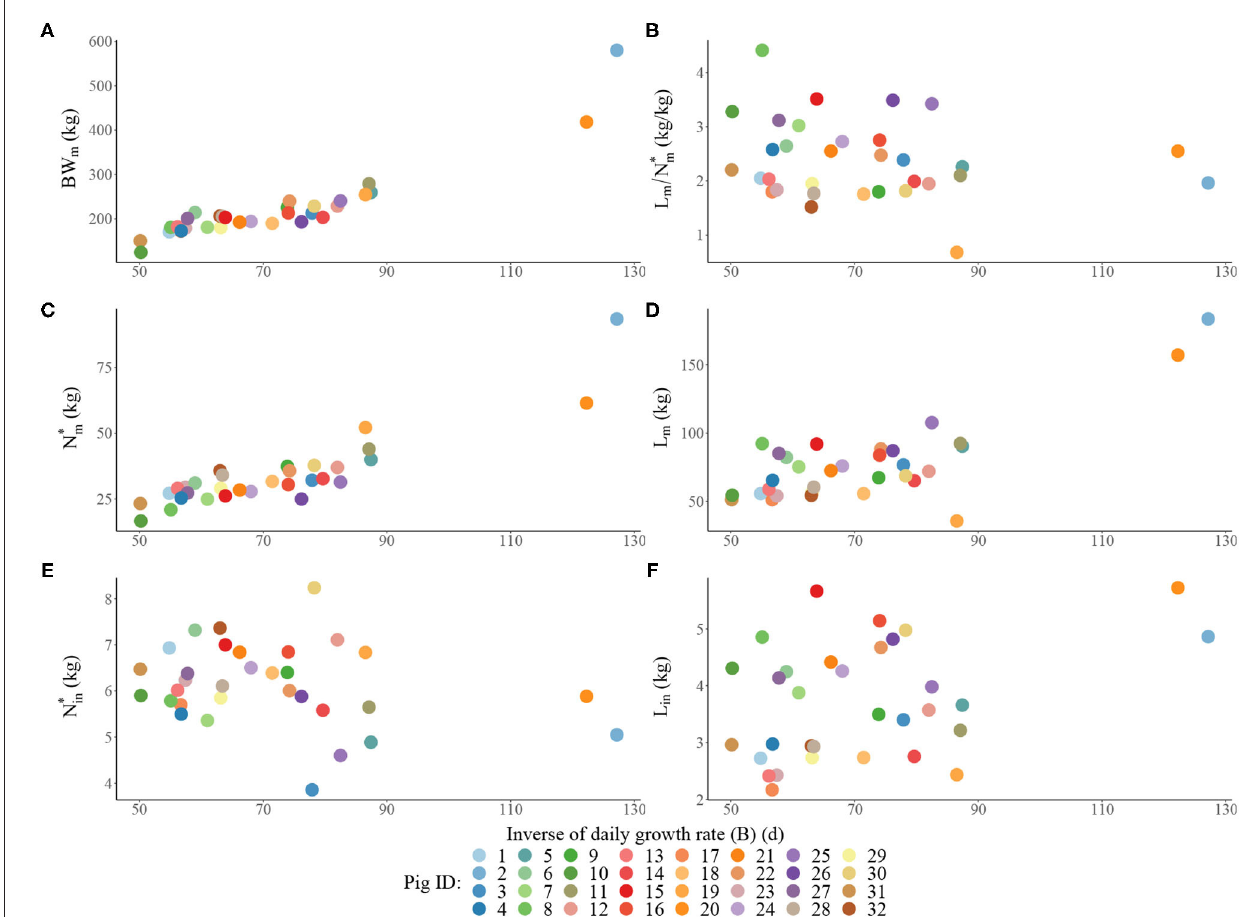
FIGURE 1 | Scatterplots of the estimated traits for each individual pig in the population: (A) mature bodyweight ( BW m ) vs. inverse of daily growth rate B B; (B) ratio of lipid to protein weights at maturity ( L m / N ∗ m ) vs. B ; (C) mature protein weight ( N ∗ m ) vs. B ; (D) mature lipid weight ( L m ) vs. B ; (E) initial protein weight ( N ∗ in ) vs. B ; (F) initial lipid weight ( L in ) vs. B